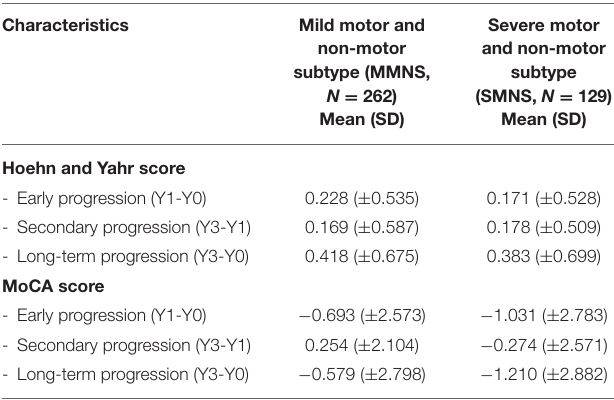
TABLE 4 | Parkinson’s disease symptom progression rate of PD